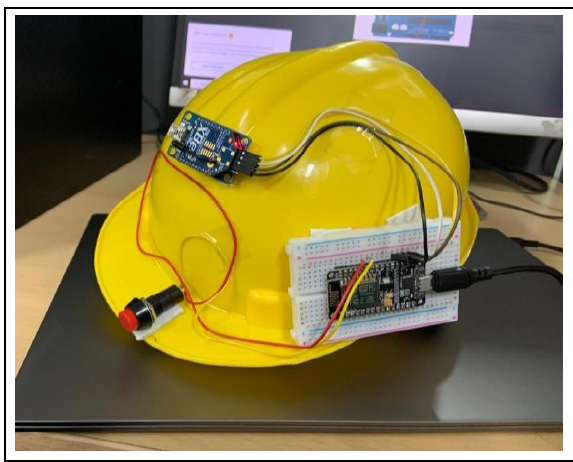
Figure 8 : Prototype of Smart Helmet